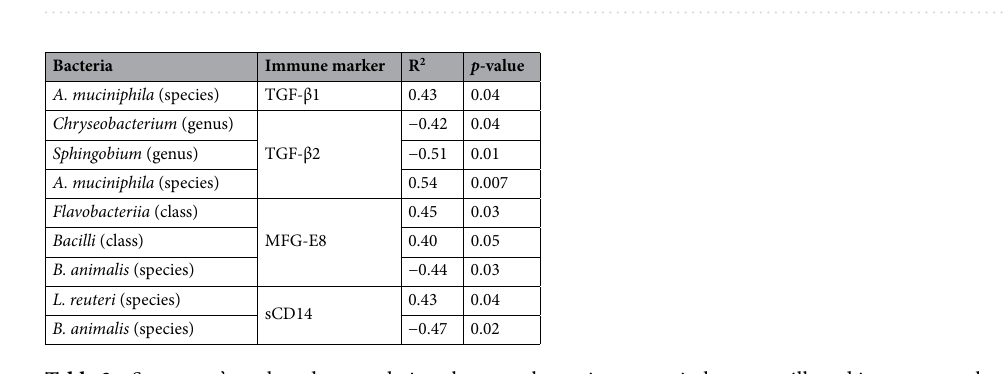
Figure 3. (A) Principal coordinate analysis (PCoA) of bifidobacteria communities in the samples analysed. The plot demonstrates clustering of different breast milk specimens [CD group (red) versus control group (blue)]. Prevalence (%) of different Bifidobacterium sp. in breast milk samples according to whole genome sequencing (B) and denaturing gradient gel-electrophoresis (C) methods. (D) Total counts (log10plasmid gene copies/ml milk) of Bifidobacterium sp. in breast milk samples of CD and control groups by real-time PCR (mean ± SD).